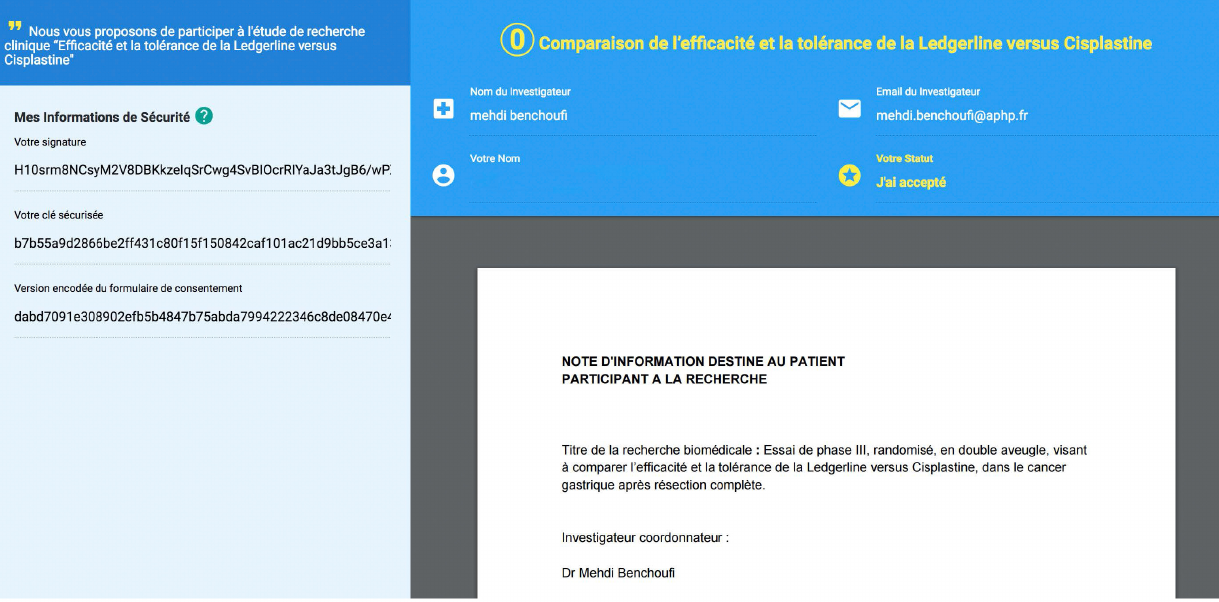
Figure 2. Patient web interface for Blockchain consent collection